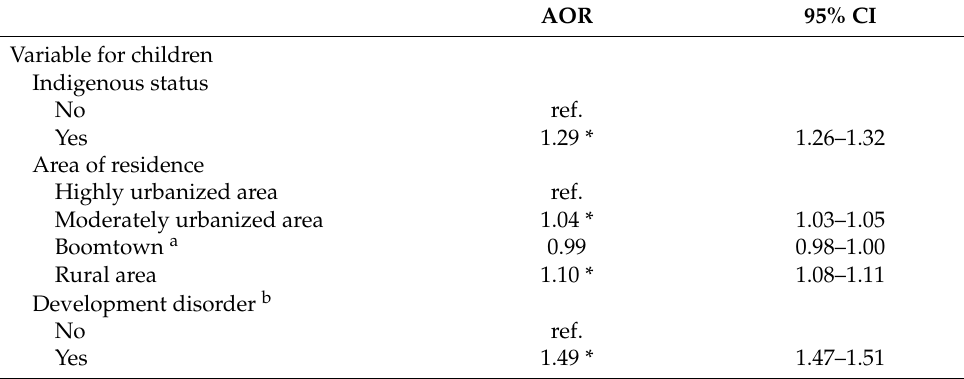
Table 2. Results of logistic regression of risk factors for child injuries. Variable for